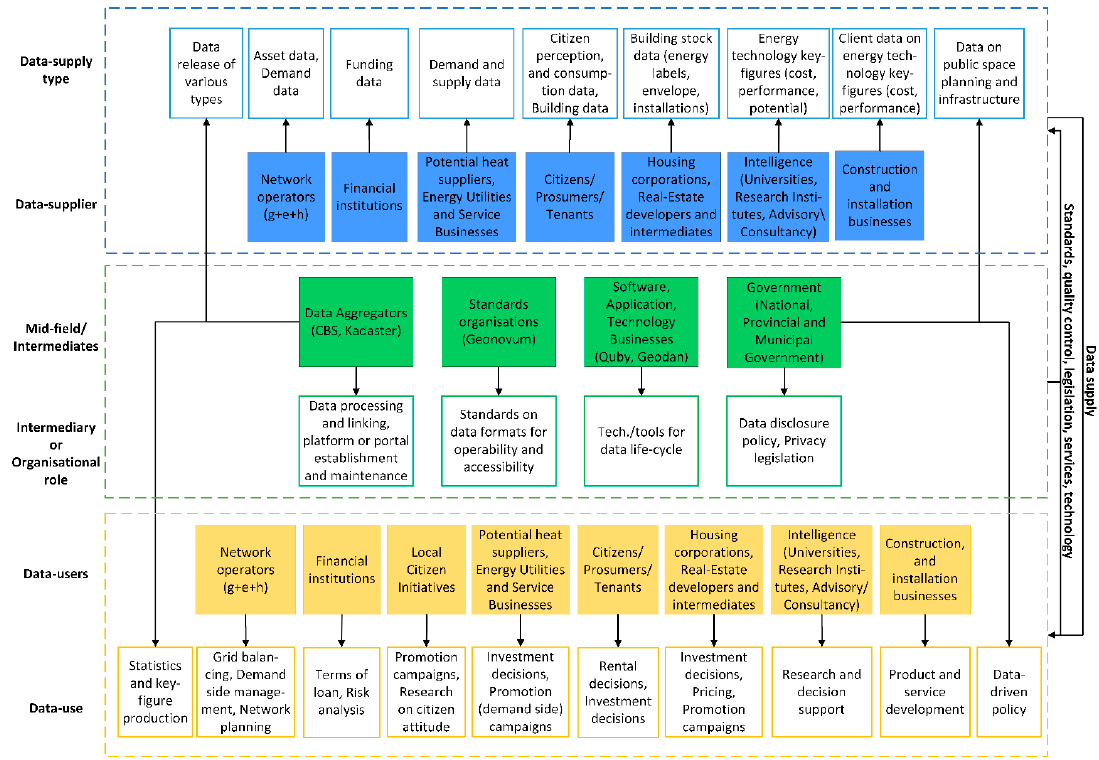
Figure 3. The data stakeholder context for the thermal energy transition in the Netherlands.